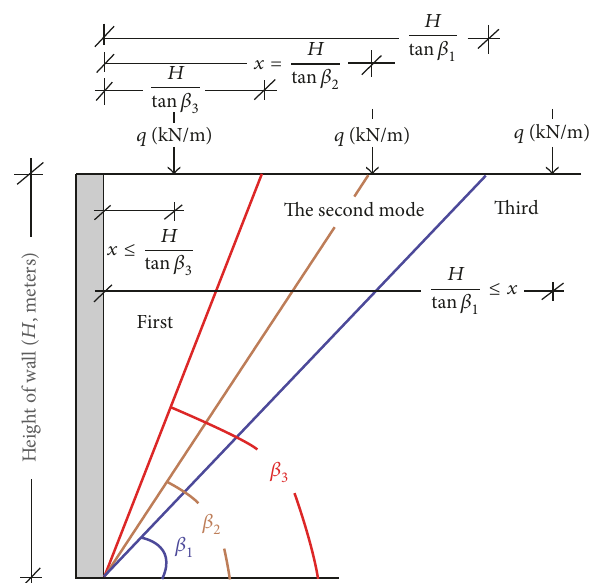
Figure 2: The distance of line surcharge from the wall in three different modes.